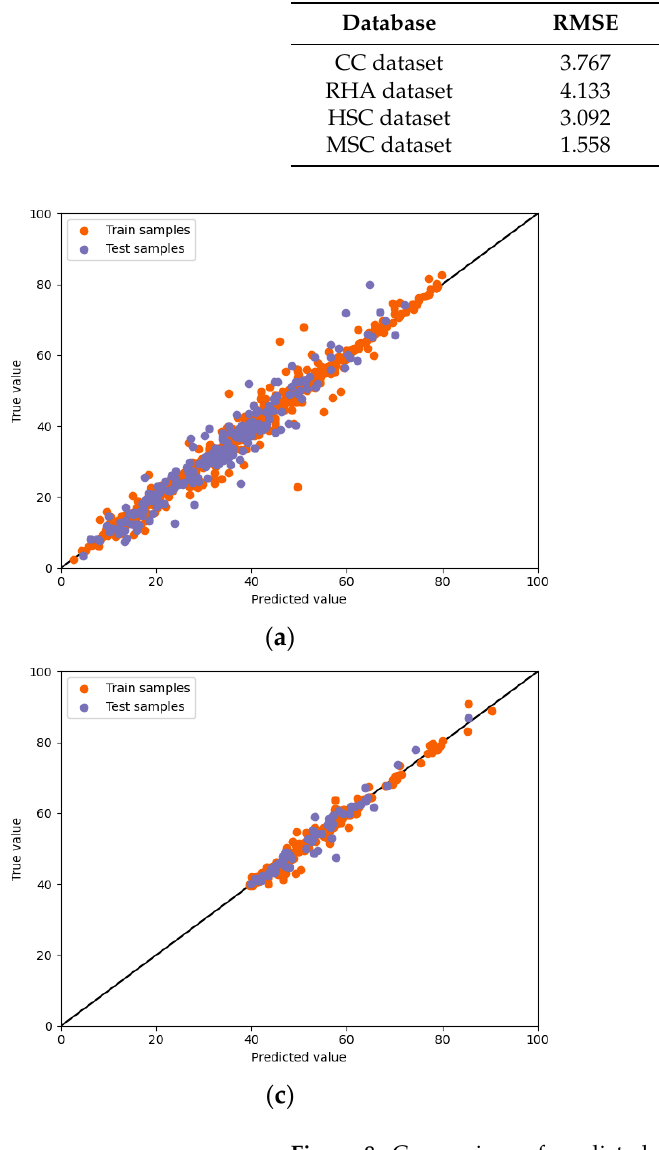
Figure 8. Comparison of predicted and true values of Auto-Sklearn for the training and test set. ( a ) CC dataset, ( b ) RHA dataset, ( c ) HSC dataset, and ( d ) MSC dataset. Table 8. Performance evaluation index values of the five ML